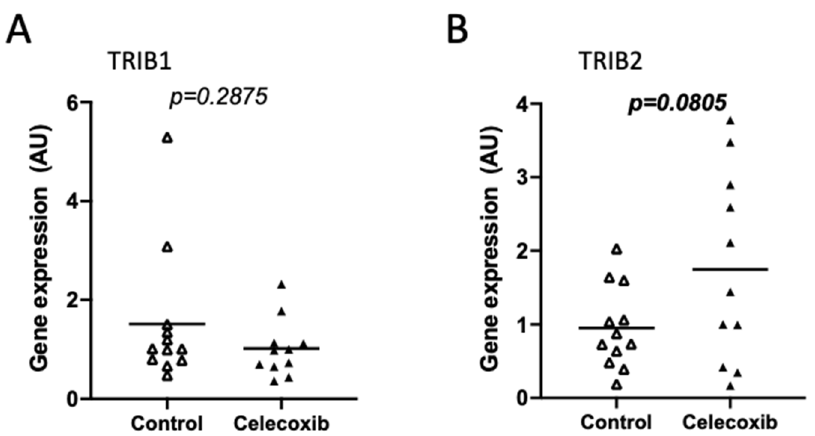
Figure 6. TRIB1 and TRIB2 gene expression in colorectal adenocarcinoma from patients treated with celecoxib. A single dataset was analyzed (GDS3384), and samples plotted individually. TRIB1 (( A )—35597_at) and TRIB2 (( B )—40113_at) gene expression from patients pre-treated with cyclooxygenase-2 (COX-2) inhibitor celecoxib (400 mg twice a day) for 7 days prior to colorectal adenocarcinoma resection (Celecoxib, n = 11), compared to non-treated patients (Control, n = 12), is represented as arbitrary units (AU). Unpaired two-tailed t test with Welch’s correction ( B ), or Mann–Whitney U test ( A ) was performed, and the p value is represented for each graph. There was no assay probe for TRIB3. The horizontal bars represent the mean of the values in each group.